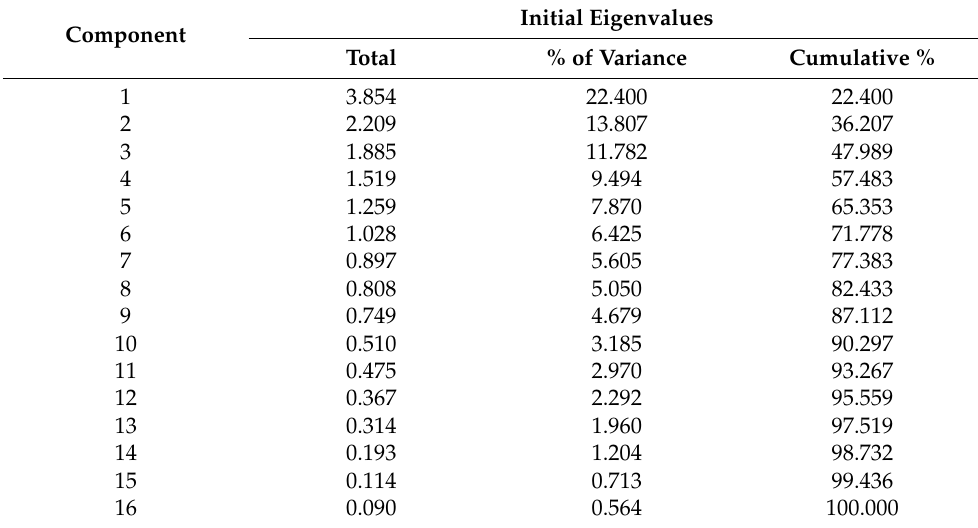
Table 6. Total variance